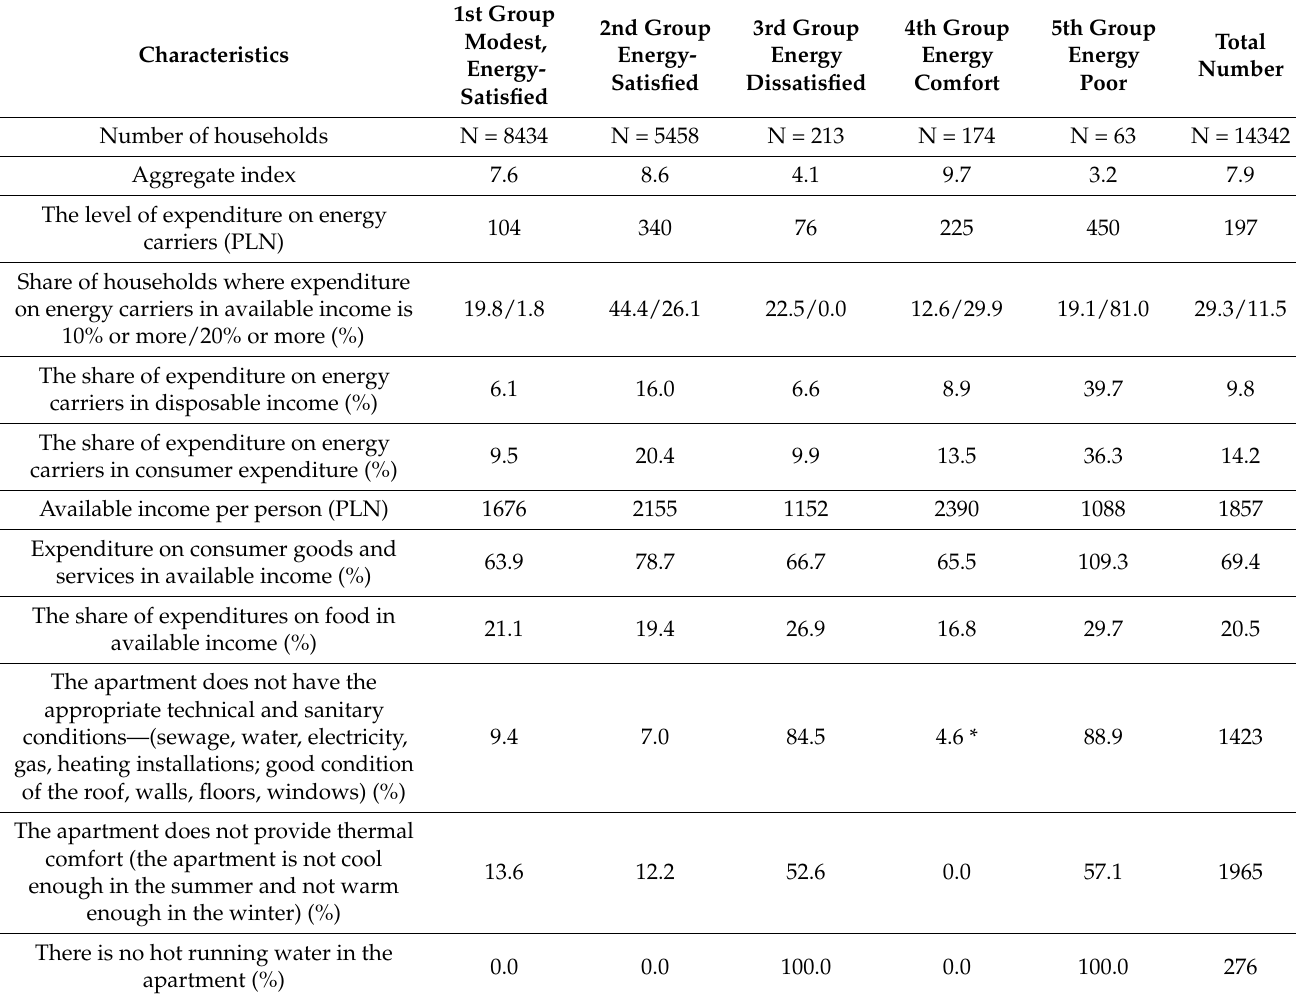
Table 4. Patterns of consumption of energy carriers of the types of households of people aged 60 and older in Poland in